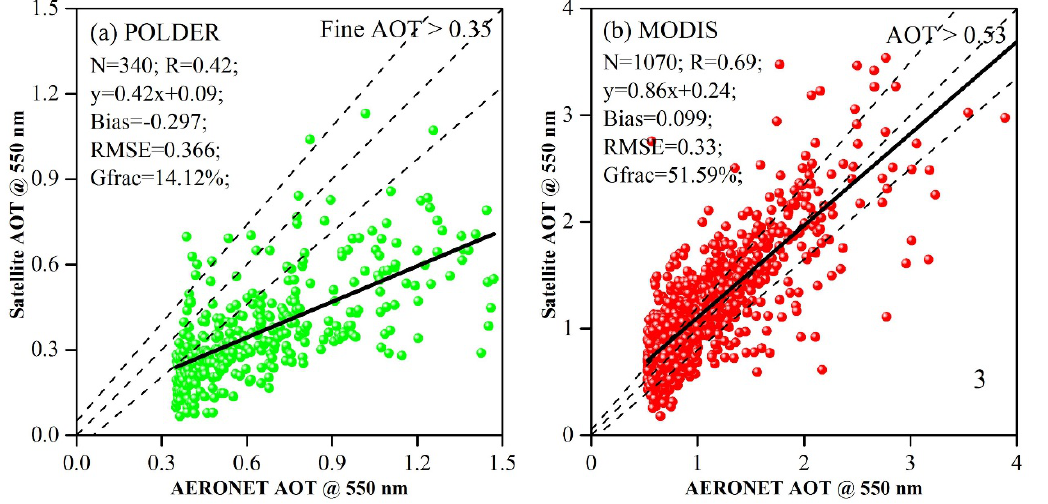
Figure 6. Scatter plot of POLDER-retrieved fine AOTs ( a ) and MODIS-retrieved AOTs ( b ) for the high aerosol loading